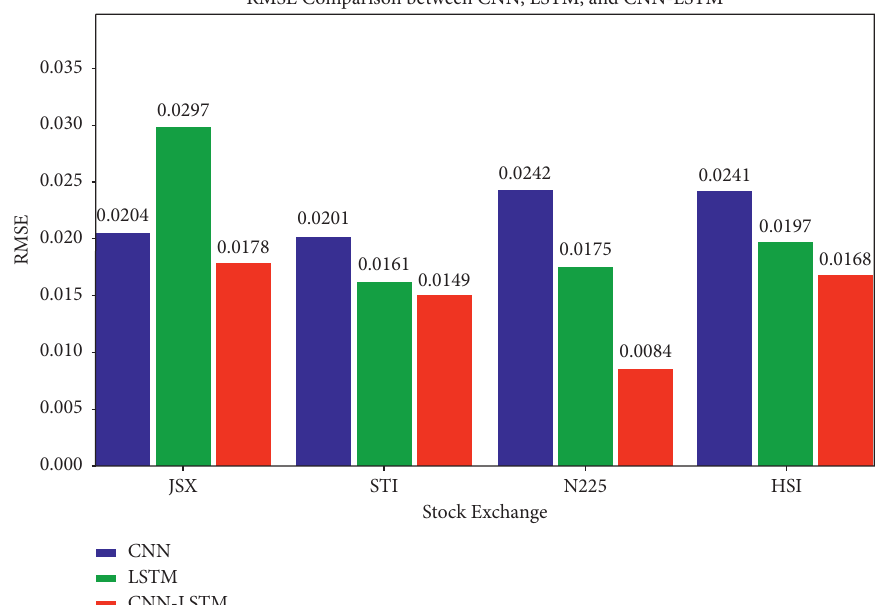
Figure 8: RMSE comparison between CNN, LSTM, and multivariate CNN-LSTM when predicting data in the testing phase, i.e., the last 72 trading days of the year 2020. Table 3: Comparison of RMSE values between CNN, LSTM, and multivariate CNN-LSTM during training and testing phase. Model